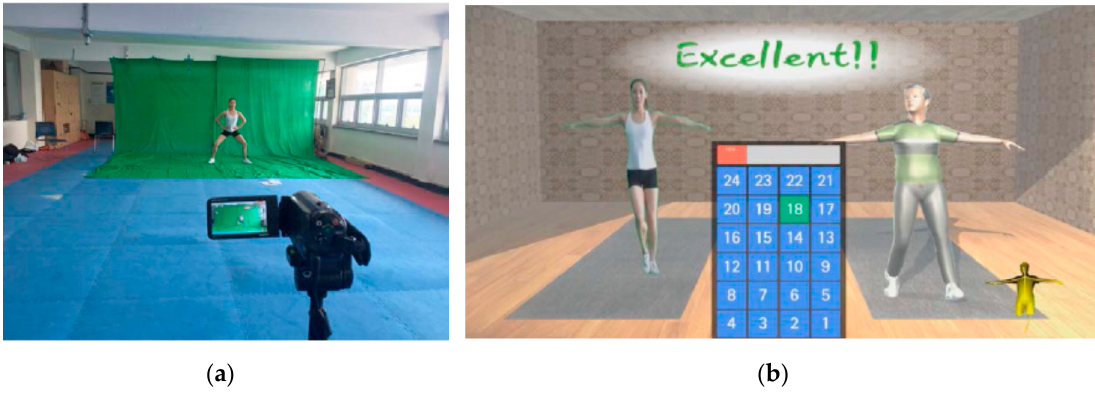
Figure 8. ( a ) Chroma-keyed trainer video capture and ( b ) exercise game scene with virtual trainer.